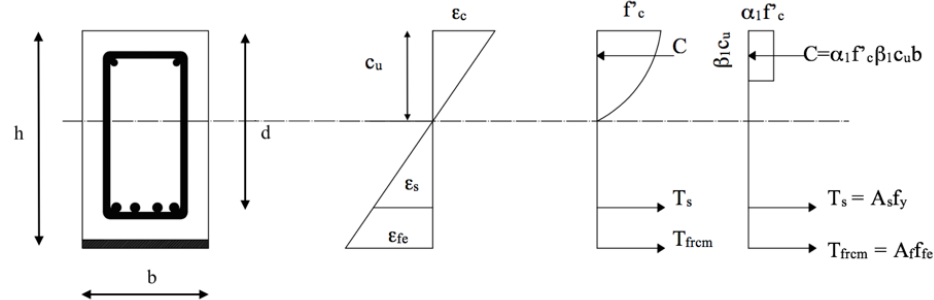
Figure A1. Flexural strength analysis for a typical FRCM-strengthened rectangular